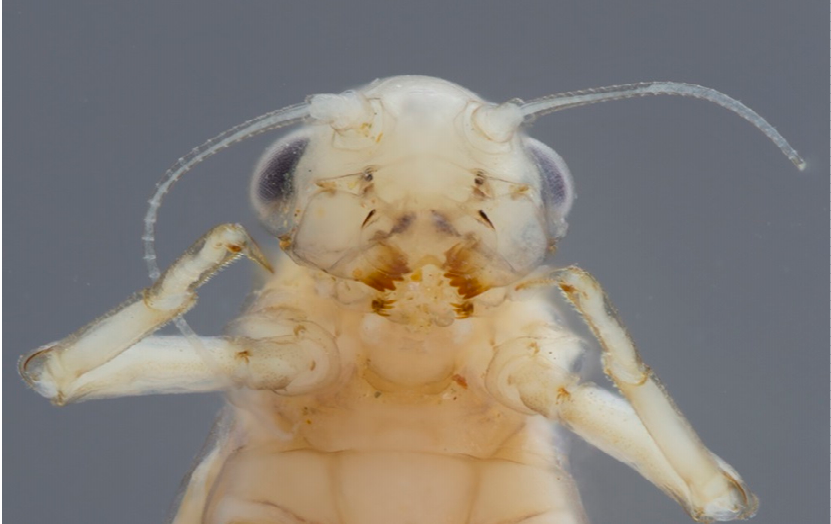
Figure 12. Edmulmeatus grandis Lugo-Ortiz & McCafferty (Baetidae, Madagascar) detail of head in ventral view; mandibles are cricket-like; this species shreds exclusively on Hydrostachys Thouars (Cornales: Hydrostachyaceae) aquatic plants and is completely green when alive.